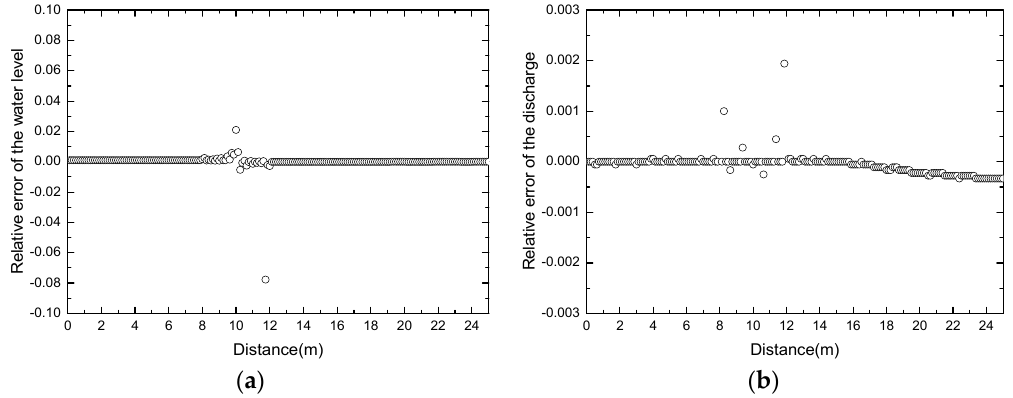
Figure 8. Transcritical flow with a shock over a bump: ( a ) comparison of the water level between numerical results and the analytical solution; ( b ) comparison of discharge.